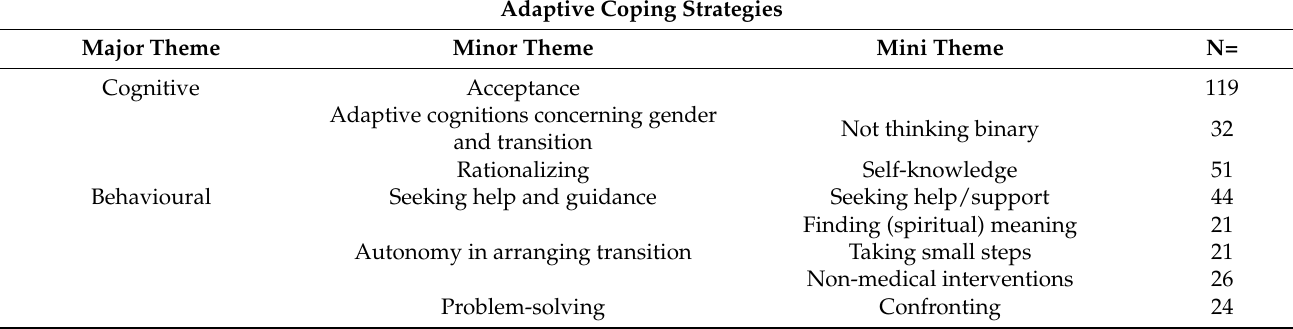
Table 3. Adaptive coping